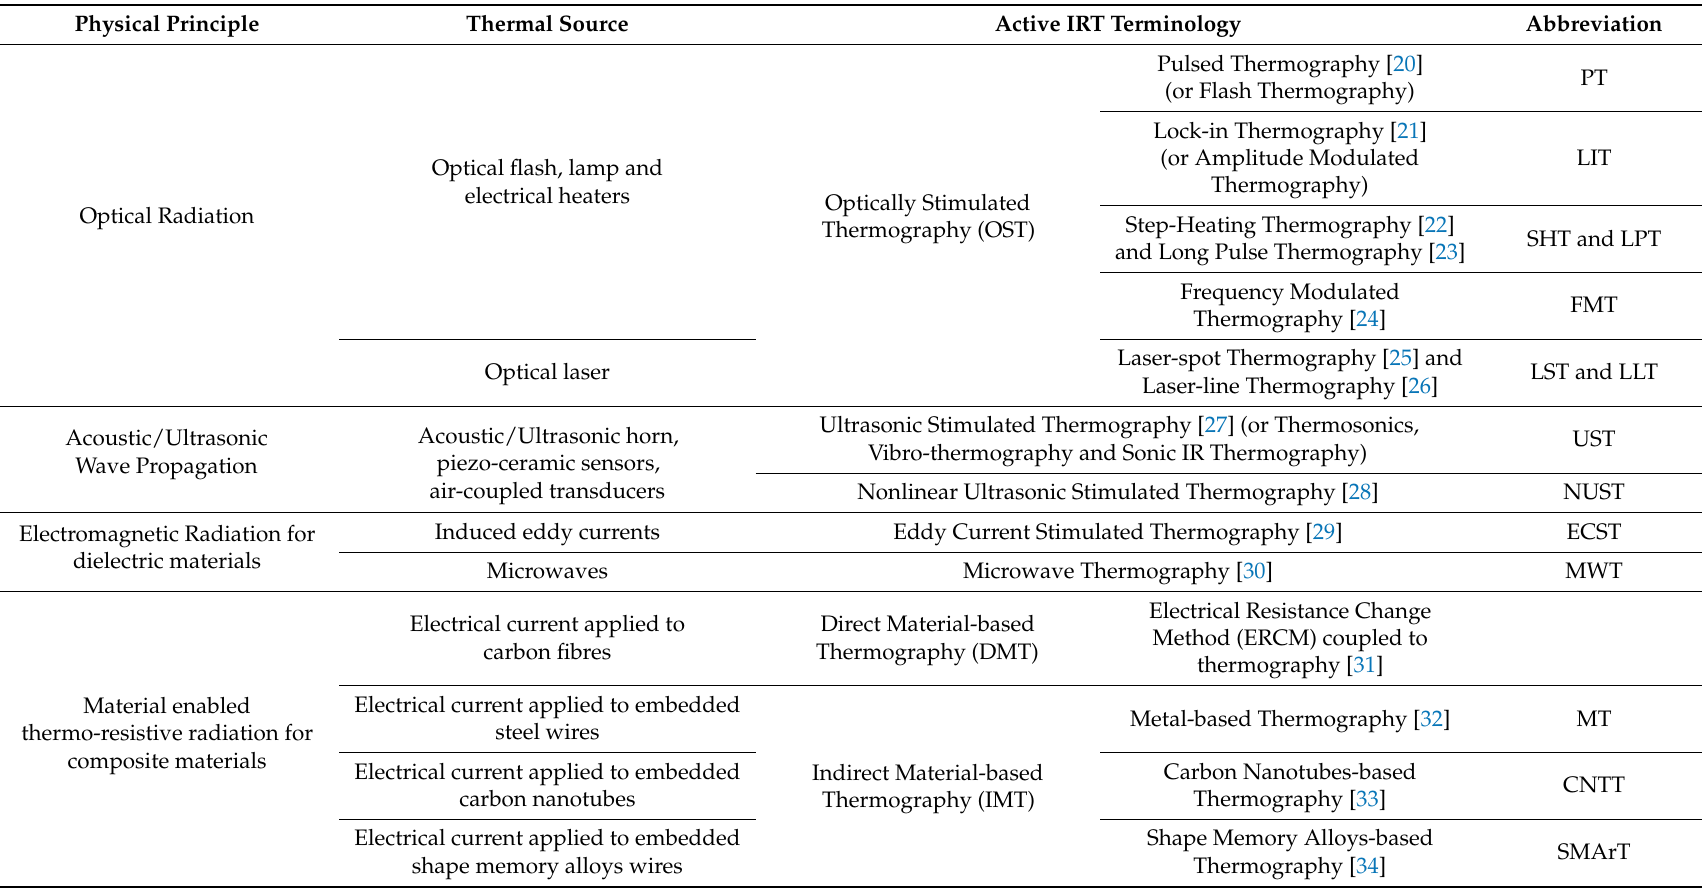
Table 2. Summary of active IRT methods used for aerospace